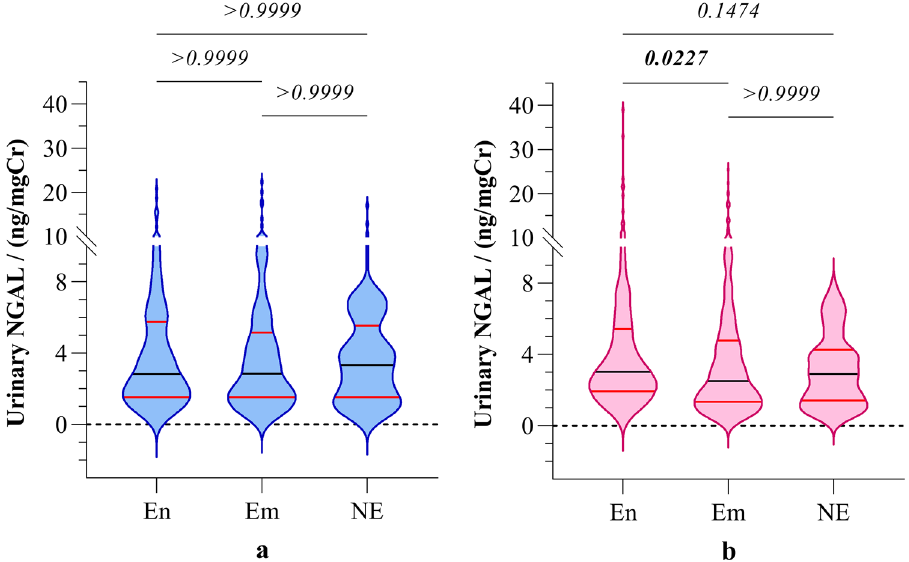
Figure 4. Gender-stratified distribution of urinary NGAL ( a ) boys and ( b ) girls from CKDu endemic, emerging, and non-endemic regions. Graphs illustrate the median and interquartile range. Inter-group comparison is expressed in terms of Kruskal–Wallis one-way analysis followed by Dunn’s multiple comparison test. The study groups: En: endemic, Em: emerging, and NE: non-endemic regions. NGAL: neutrophil gelatinase associated